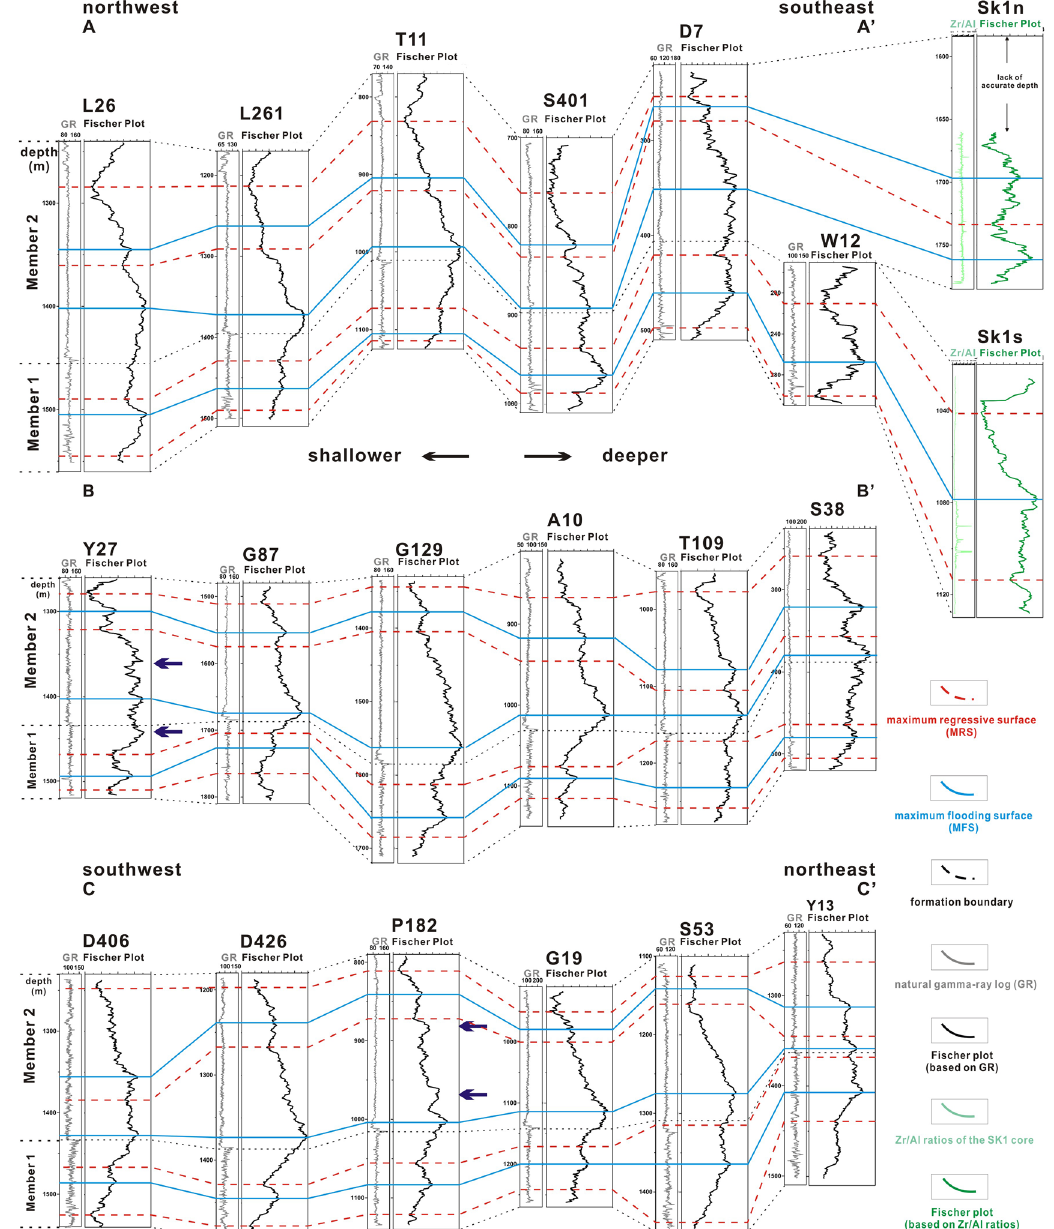
Figure 5. Three cross-sections ( A – A ′ , B – B ′ and C – C ′ ) of Fischer plots based on natural gamma-ray logs. Sampling positions are shown in Fig. 4. Blue lines and red dashed lines represent correlatable maximum flooding/regressive surfaces. Blue arrows indicate local tectonics controlled